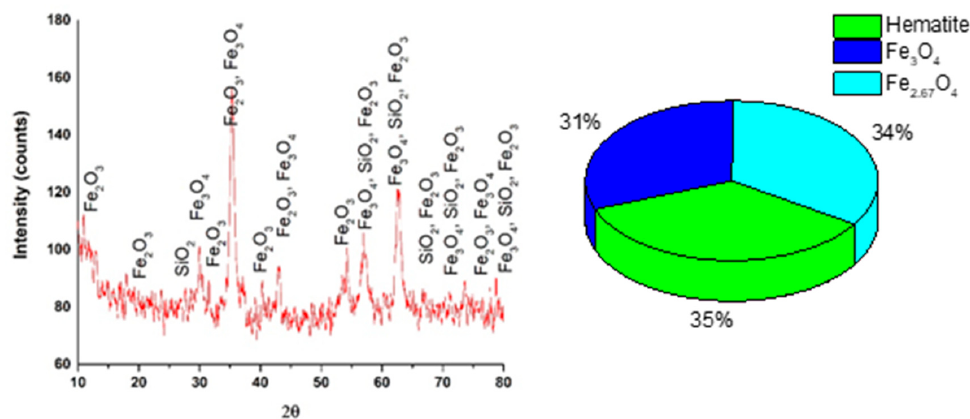
Figure 4. X-ray diffraction of the MS powder and percentage of identified phases (inset).